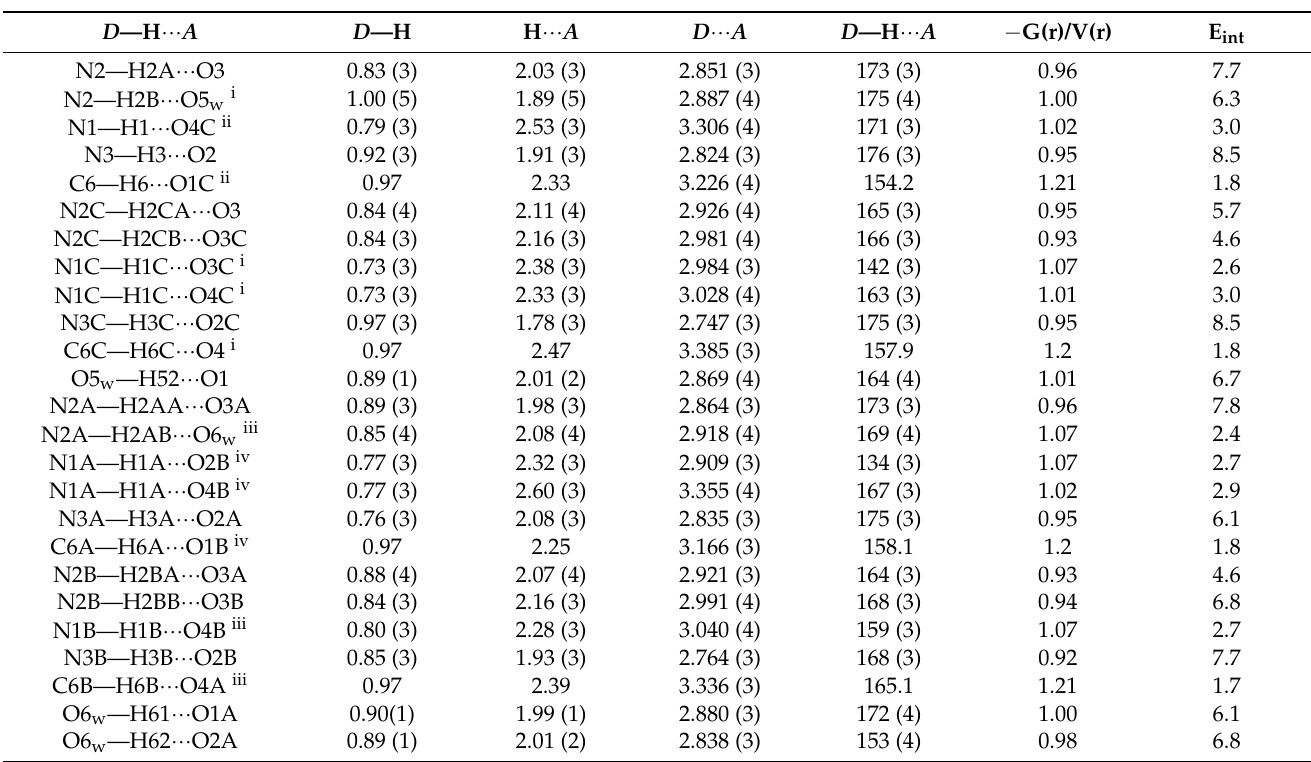
Table 3. Hydrogen-bond geometry (Å, ◦ ) and topological analysis for compound ( III ). E int is reported in kcal/mol. For additional details concerning QTAIMS results see Tables S5–S7 in the Supporting